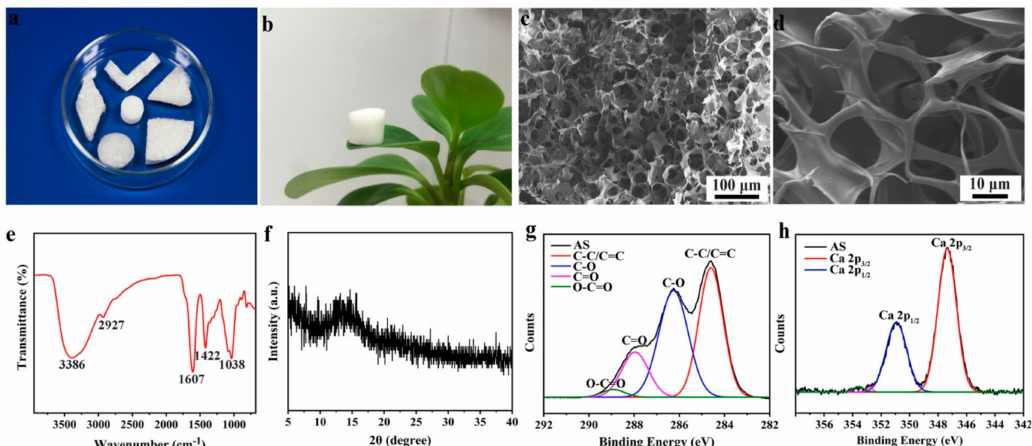
Figure 1. ( a ) Photographs of AS with desired shapes which is easy to be handled and cut by scissors; ( b ) a photograph of a column of AS free-standing on a grass leaf to support its weight; ( c , d ) SEM images of AS samples with di ff erent magnifications; ( e ) the FT-IR spectra and ( f ) the XRD pattern of AS; ( g , h ) high-resolution XPS of C 1s peaks and Ca 2p peaks for